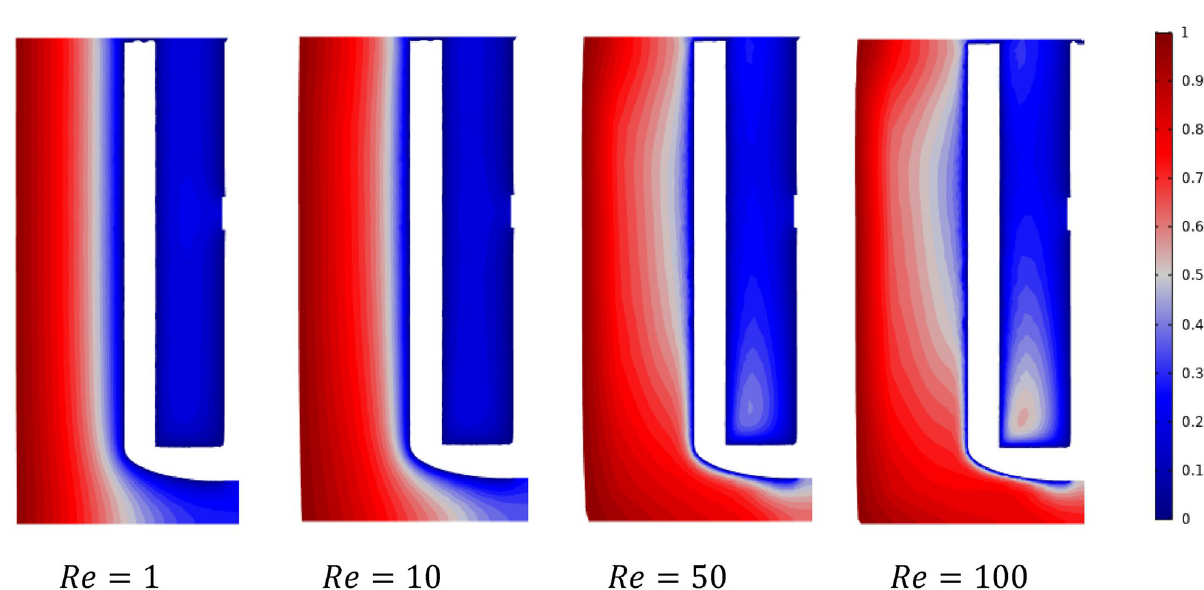
Figure 12. Contour velocity distribution in the horizontal impeller section on the stirred tank for different Reynolds